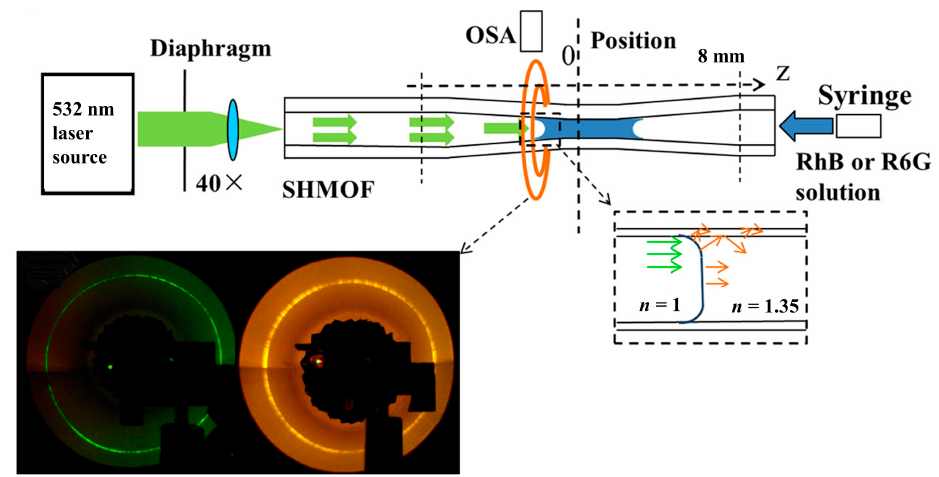
Figure 7. Schematic diagram of simplified hollow microstructure fiber microcavity laser [58].